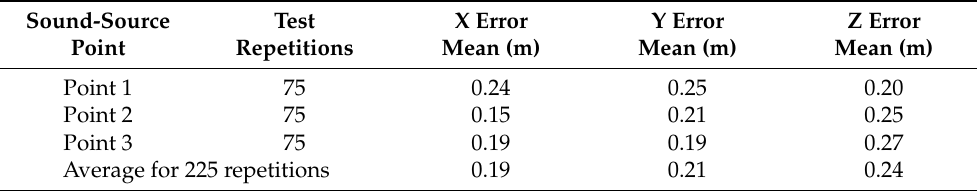
Table 7. Results of the exterior validation test 3.